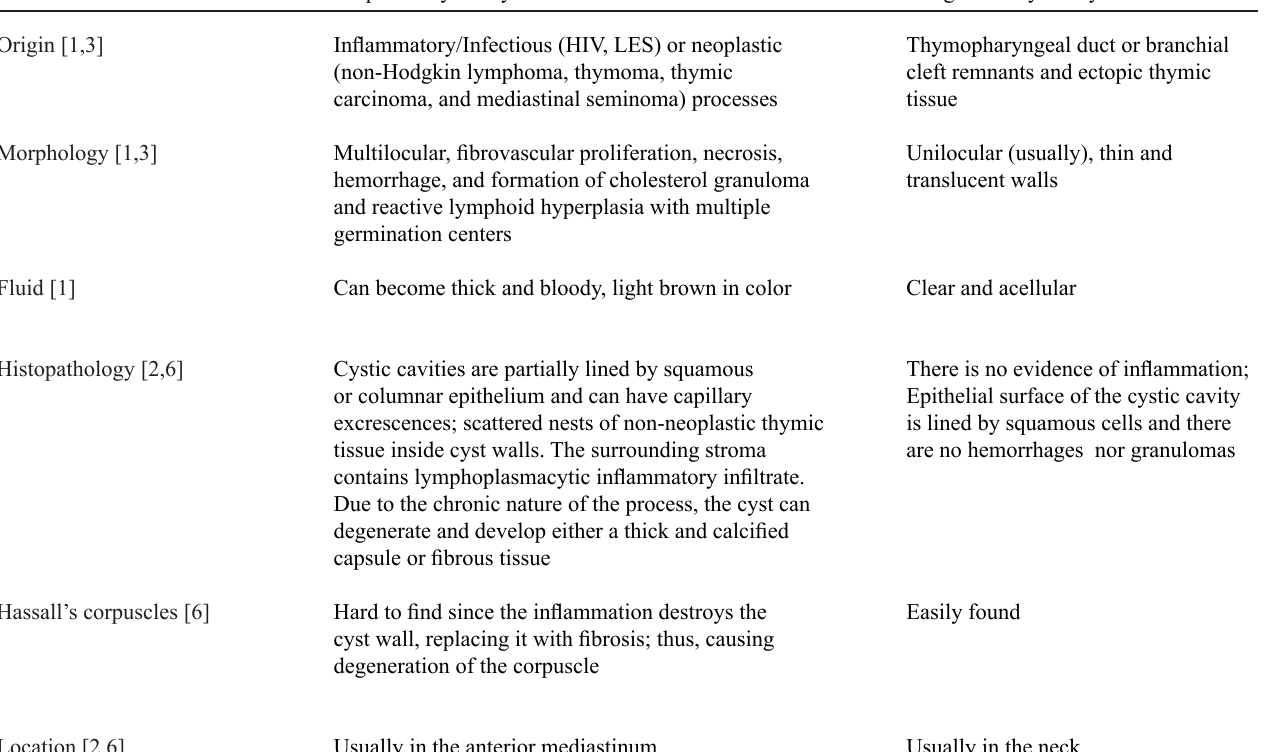
Table 1. Morphological differences between acquired and congenital thymic cysts Characteristic Origin